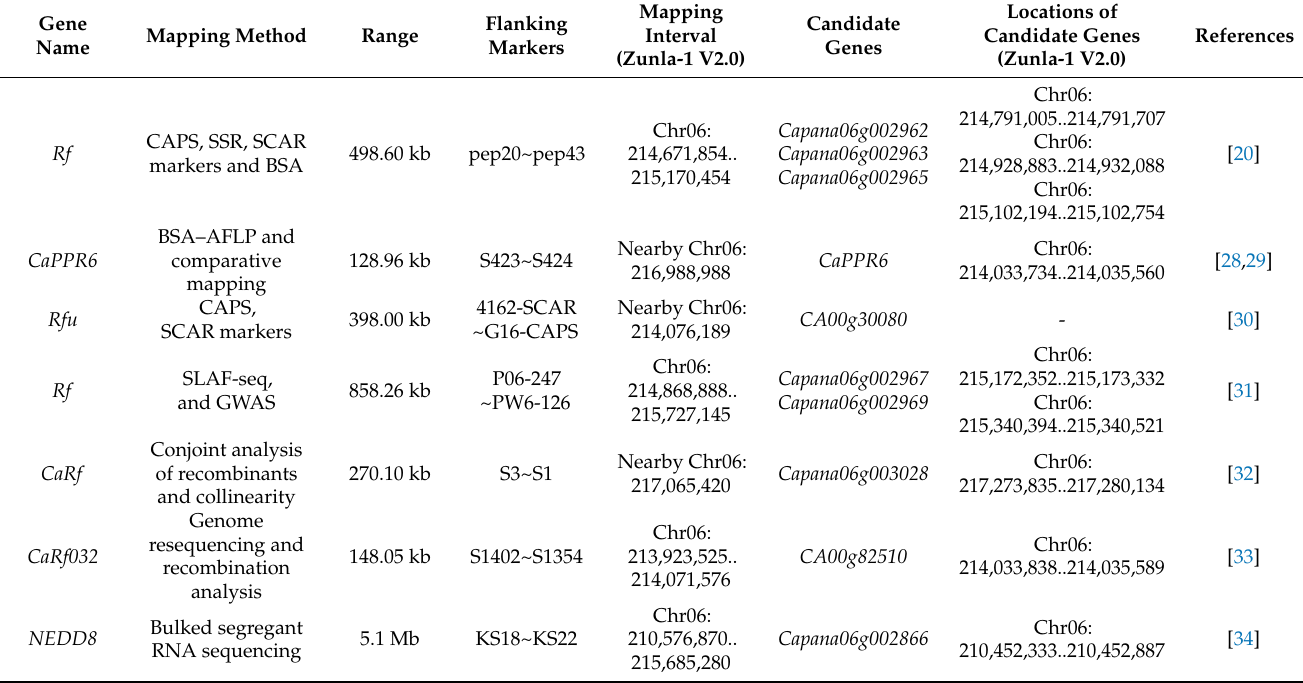
Table 1. Reported Rf candidate genes on chromosome 6 in